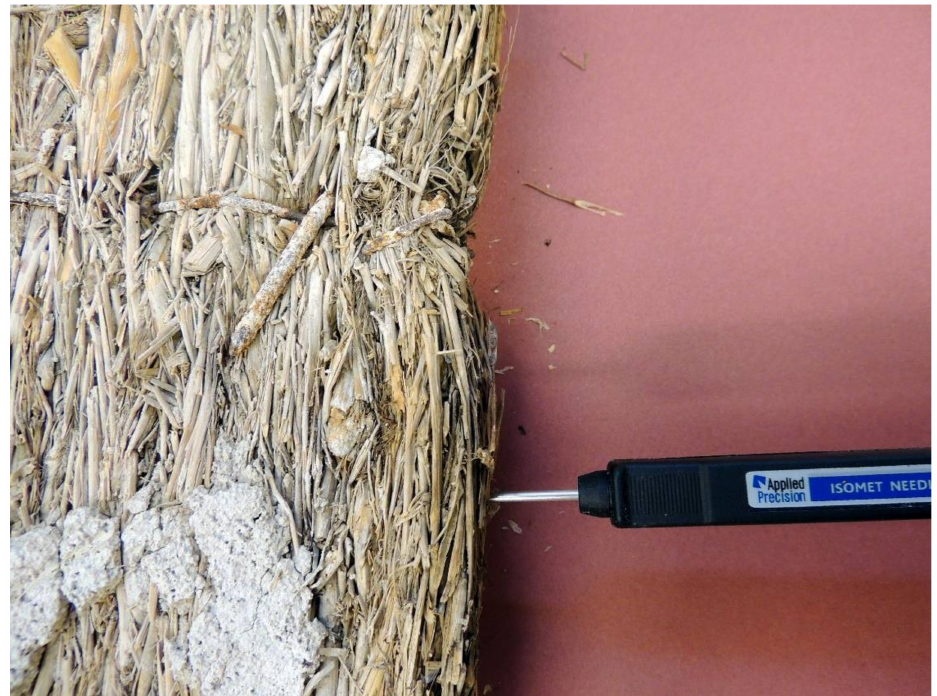
Figure 7. Needle sensor pressed into the material during the